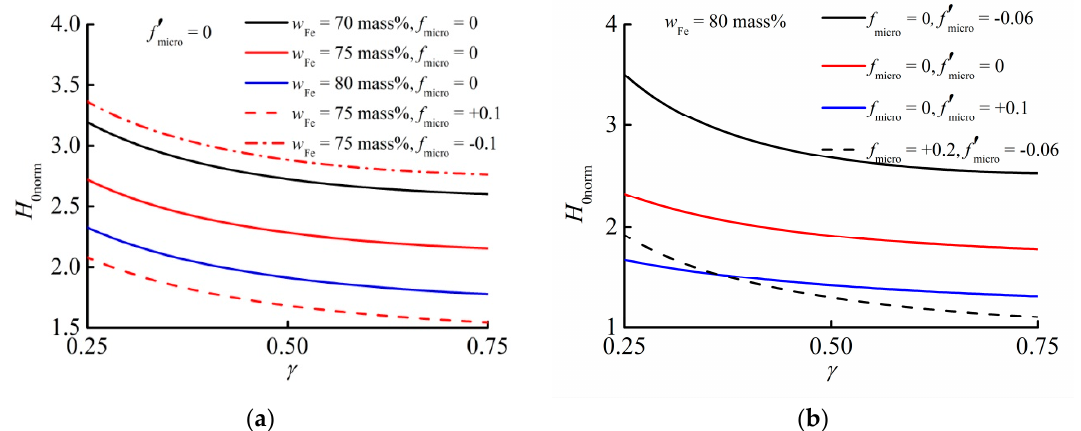
H on the aspect ratio γ . 0norm (cid:44) 0 at f ≠ at micro micro at fixed micro f ′ at in micro micro f and micro